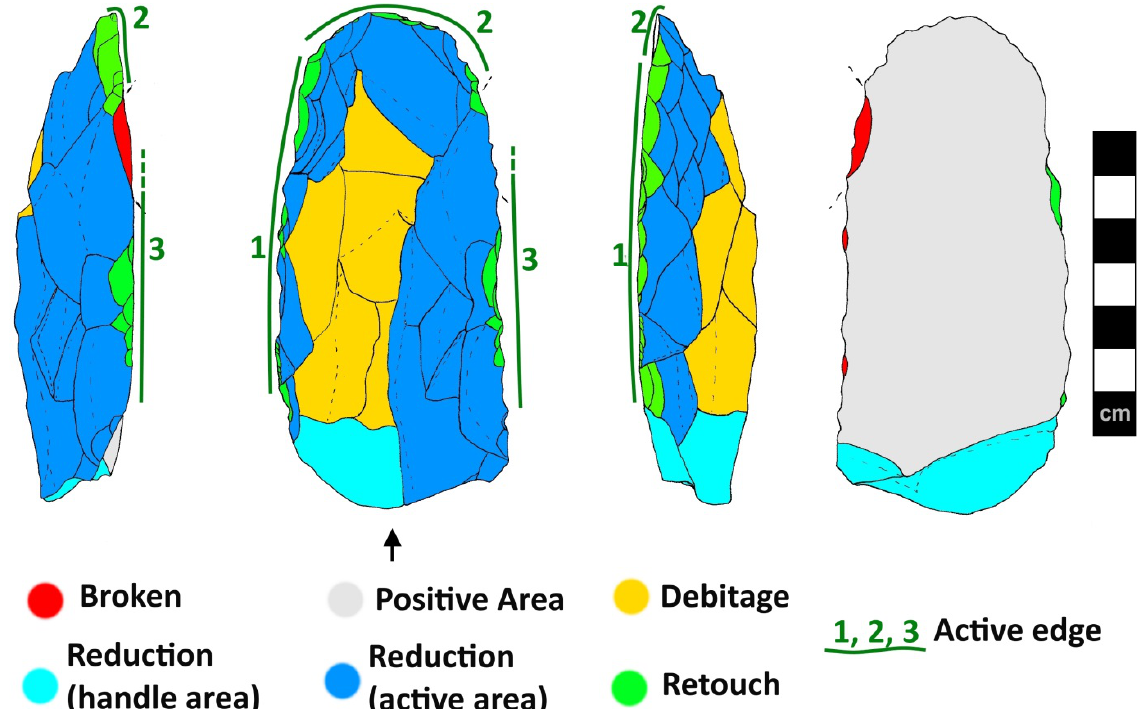
Figure 9. Artifact production stages and transformative UTFs locations. Limace found at Lapa de Taquaraçu archaeological site. Sclae bar has 7 cm. Scheme drawing by João Carlos Moreno da